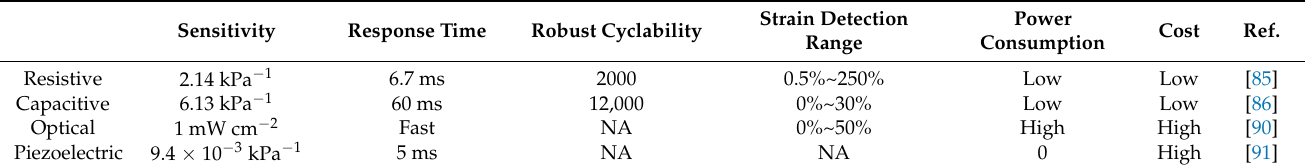
Table 2. Summary of the four types of